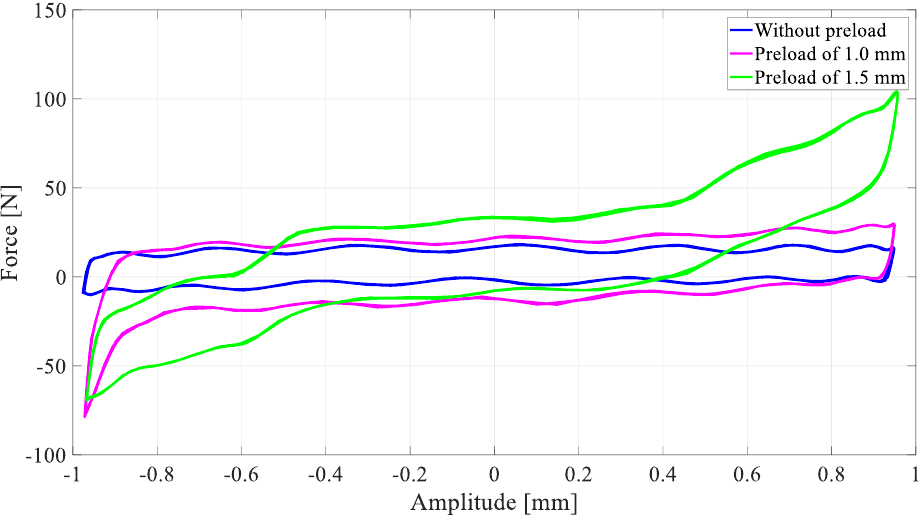
Figure 13. Force versus amplitude for dynamic test with the M-Shape device applied in the support bearing.